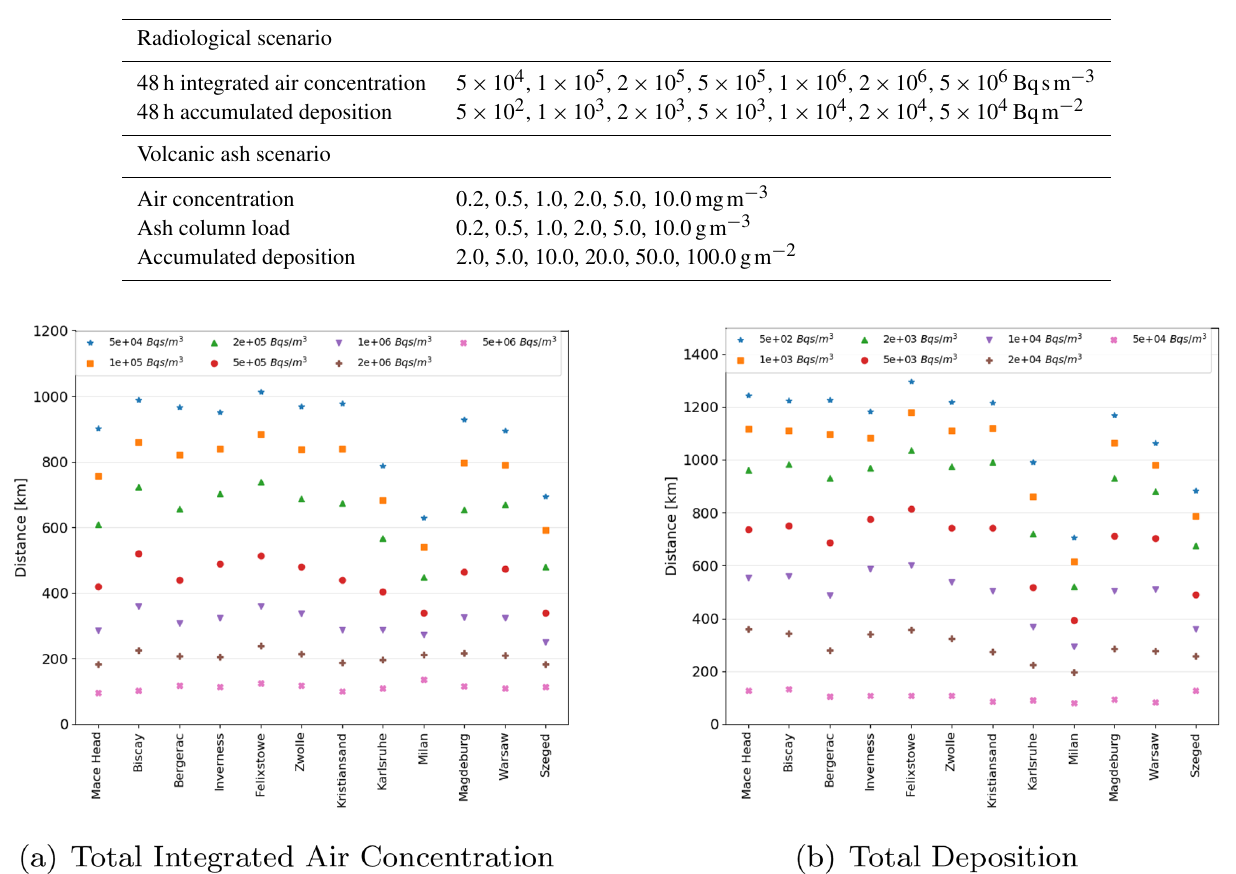
Figure 2. Average maximum distances at which thresholds are exceeded for (a) total integrated air activity of Cs-137 and (b) total accumu- lated deposits of Cs-137 for each of the 12 release locations and each of the six